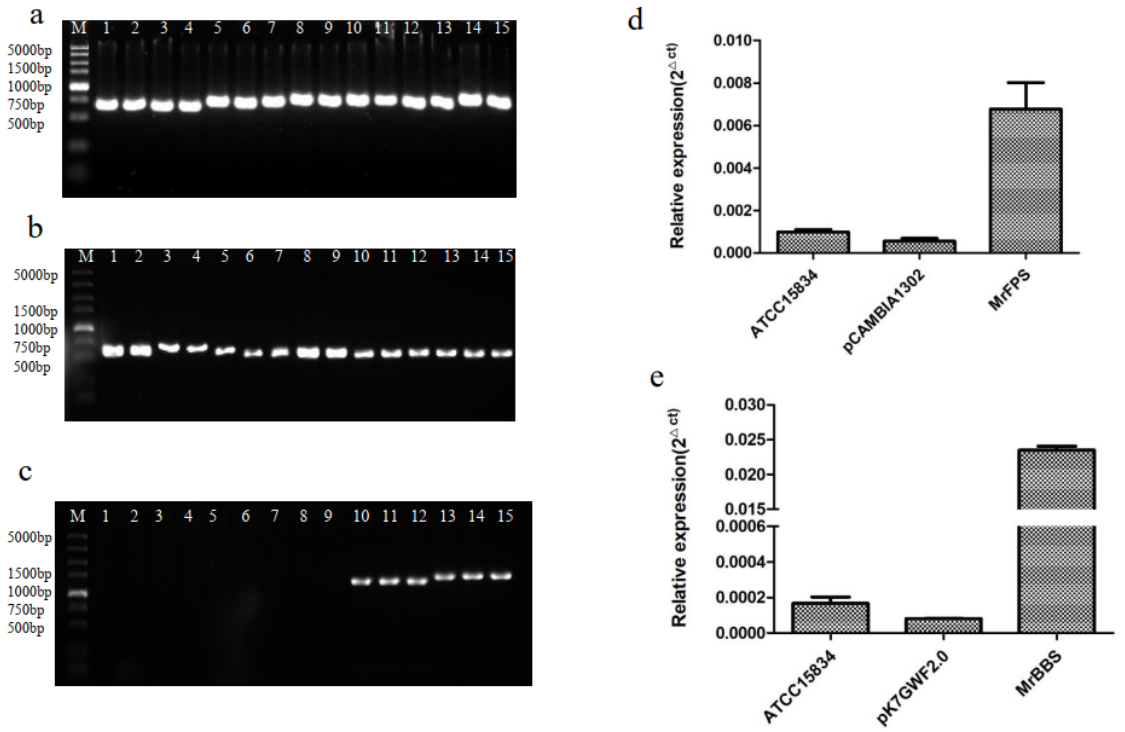
Figure 2. PCR analysis of DNA from MrFPS ( a ) and MrBBS ( b ) transgenic hairy roots using primers specific to the rol B and rolC genes. ( c ) PCR analysis of DNA from transgenic hairy roots using primers specific to MrFPS and MrBBS. Note: Lane M, markers; c: lanes 1–3, ATCC15834 DNA; lanes 4–6, pK7GWF2.0 DNA; lanes 7–9, Pcambia1302; lanes 10–12, PCR products of MrBBS from putative transformant; lanes 11–15 , PCR products of MrFPS from putative transformants; qPCR analysis on DNA from wild-type roots and overexpression of MrFPS in hairy roots ( d ); qPCR analysis on DNA from wild ‐ type roots and overexpression of MrBBS in hairy roots ( e ).